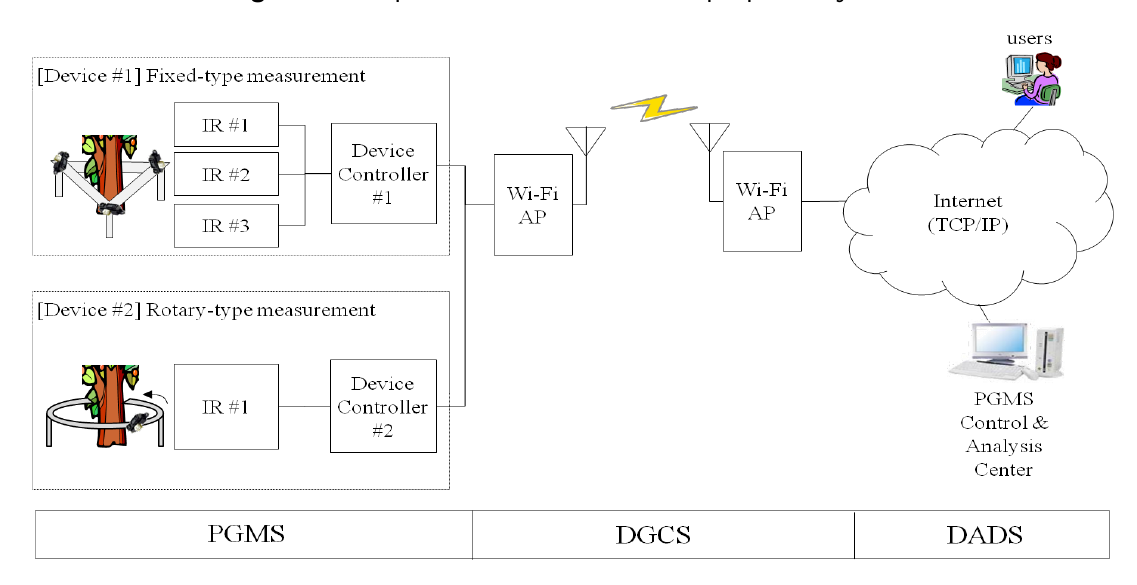
Figure 8. Simplified architecture of the proposed system.